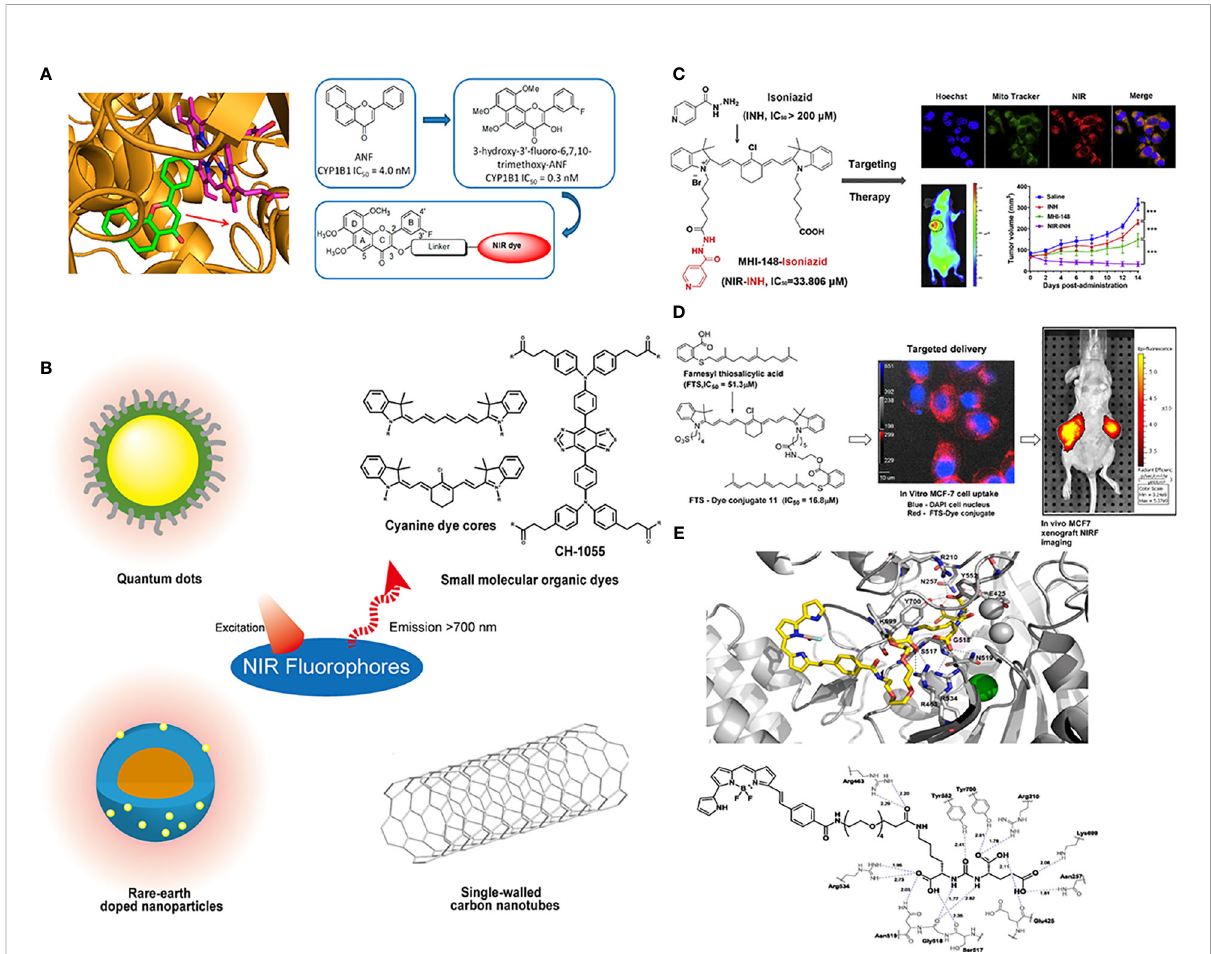
FIGURE 5 Conjugations between inhibitors and NIR fl uorophores. (A) Conducting molecular docking analysis of CYP1B1 inhibitor and its target before conjugation to avoid the loss of af fi nity. Reprinted with permission (42). Copyright 2018 American Chemical Society. (B) The common types of NIR fl uorophores. (C) Conjugating with the heptamethine cyanine dye MHI148 can improve the antitumor effect of the MAO-A inhibitor isoniazid. Reprinted with permission (43). Copyright 2018 Elsevier. (D) The conjugation of FTS with cancer-targeting heptamethine cyanine dye improved its pharmacological pro fi le. Reprinted with permission (44). Copyright 2017 American Chemical Society. (E) Molecular docking results demonstrated a 20 Å tunnel region in PSMA. Reprinted with permission (45). Copyright 2020